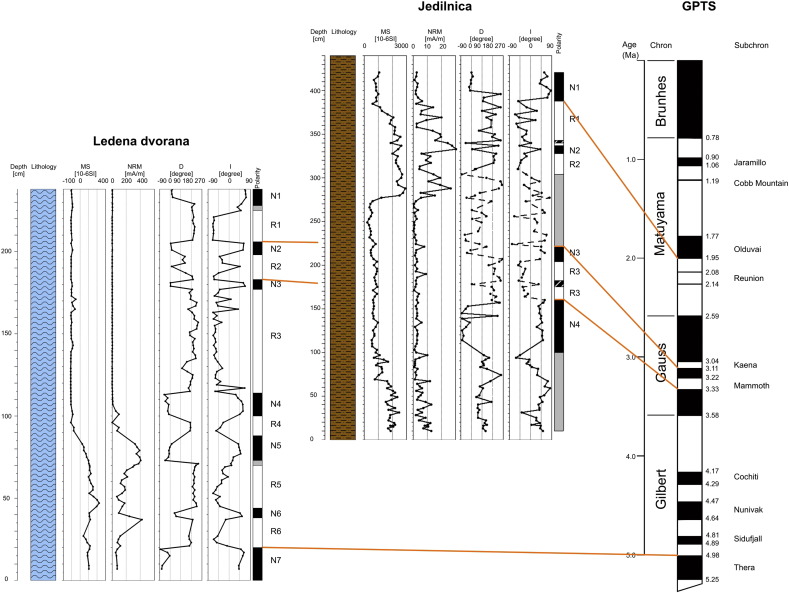
Correlations of magnetostratigraphy interpretation of speleothem profile in Ledena dvorana (modified from Bosák et al., 2002), siliciclastics in Jedilnica and the GPTS (modified from Cande and Kent, 1995). Compare with Table 6.Explanations: profiles of basic magnetic and magnetostratigraphic parameters: blue—speleothems; brown—siliciclastics; magnetostratigraphy columns: white—R polarity; black—N polarity; grey—transient polarity.